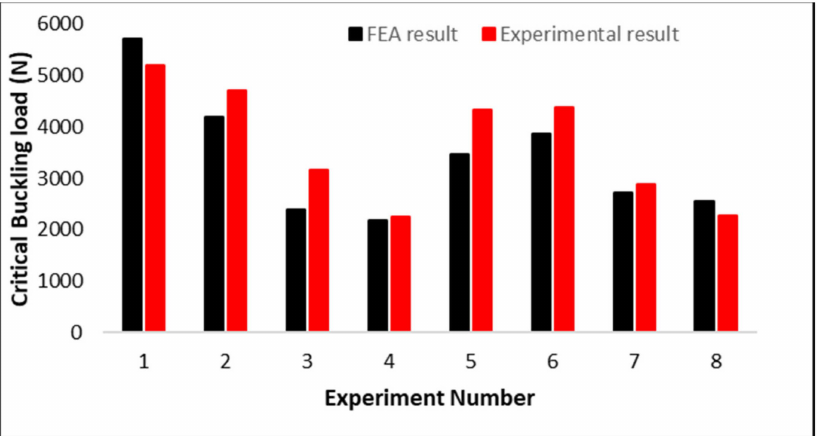
Figure 14. Comparison of experimental and simulation results as indicated in Table